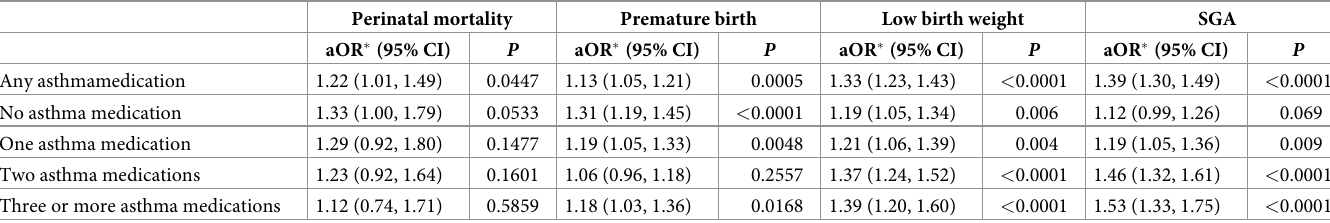
Table 3. Perinatal outcomes of treated, confirmed asthma by ATC-groups compared to controls for singleton live and stillbirths.